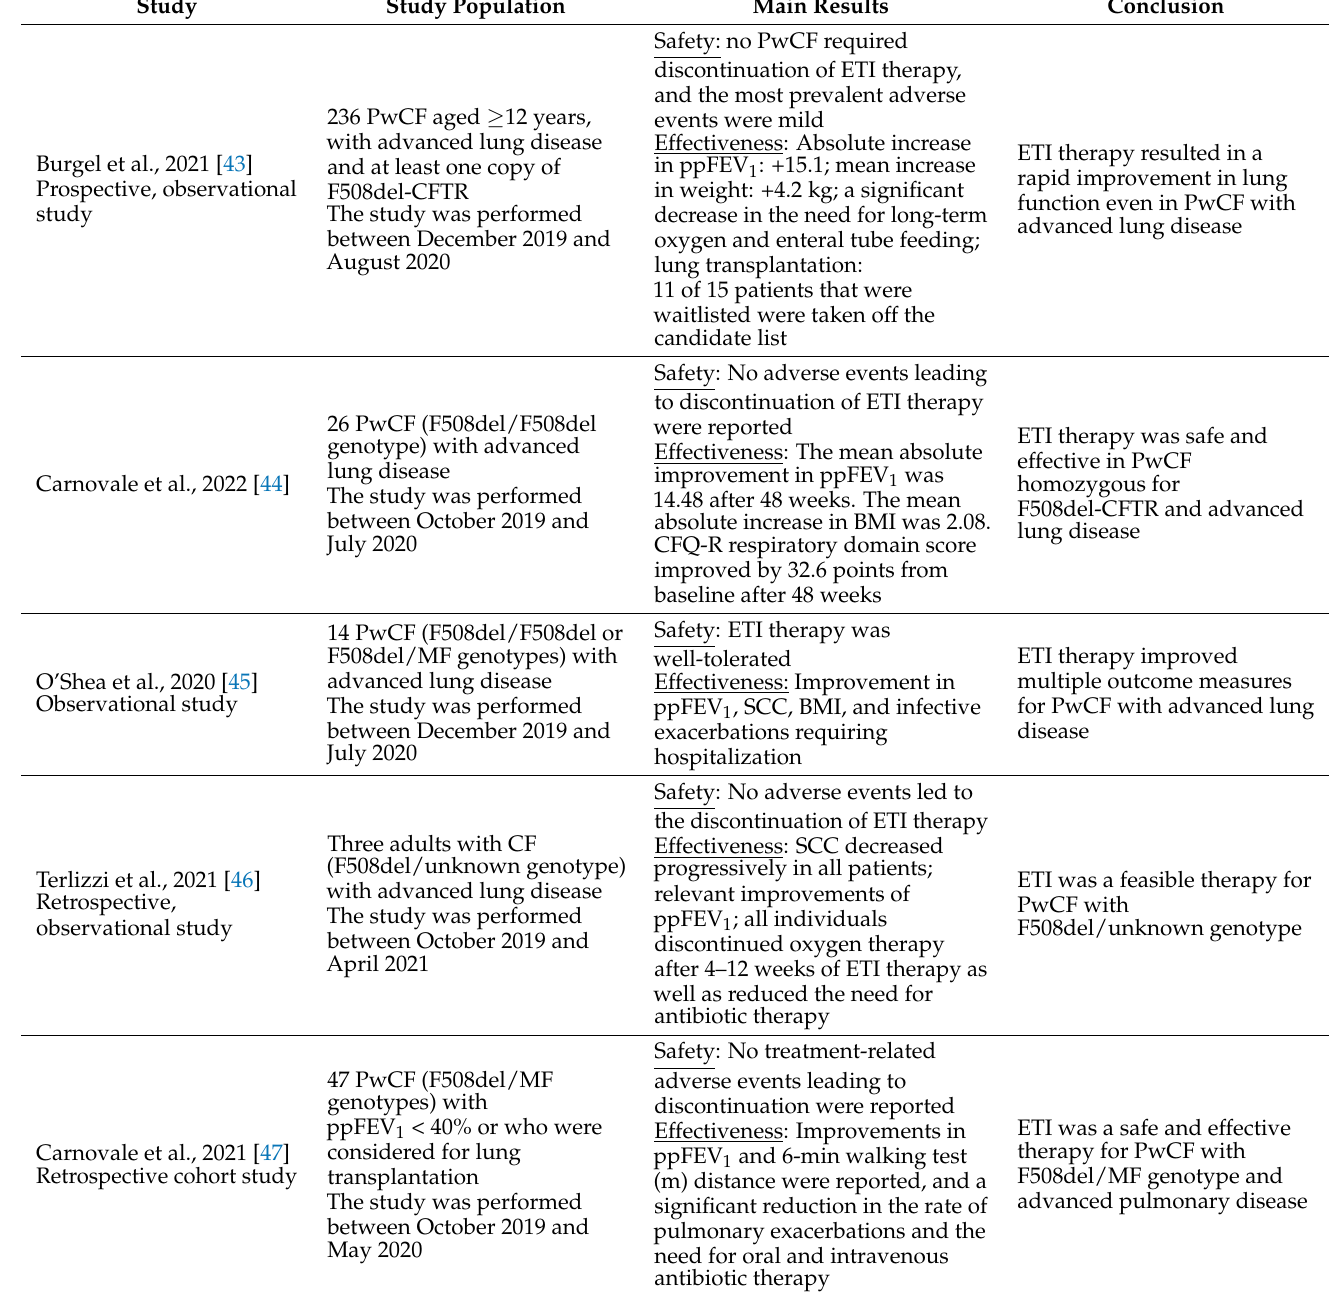
Table 3. Clinical studies assessing the effects of ETI therapy in PwCF carrying at least one F508del- CFTR allele and advanced lung